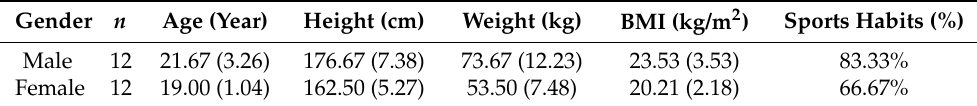
Table 1. Baseline characteristics of the participants.